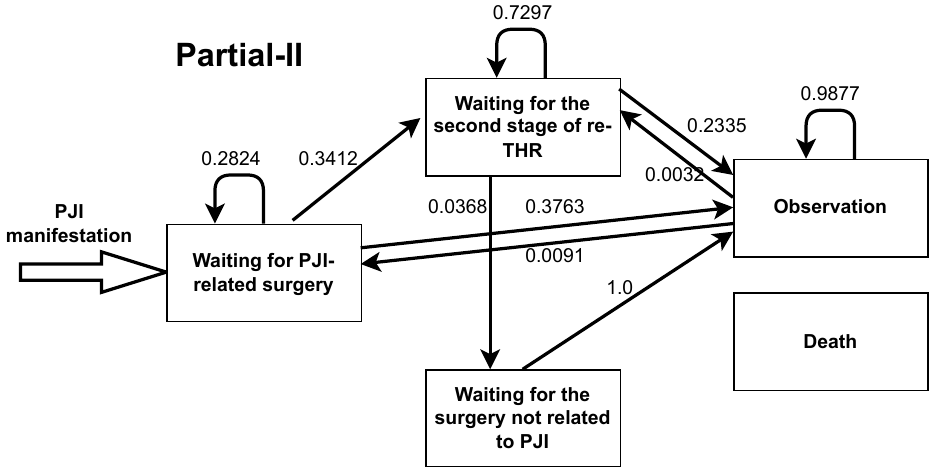
Figure A8. Markov model transition probabilities for partial two-stage total hip